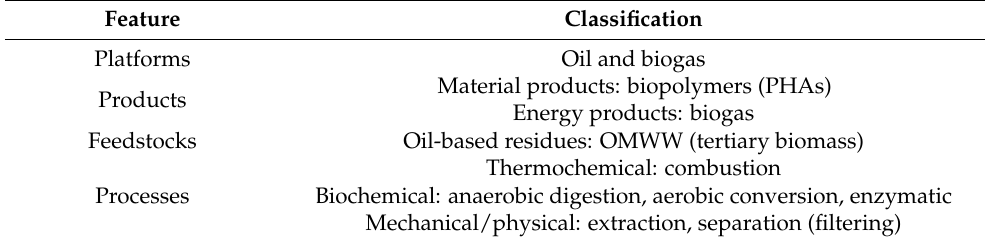
Table 3. Classification of the planned biorefinery (based on